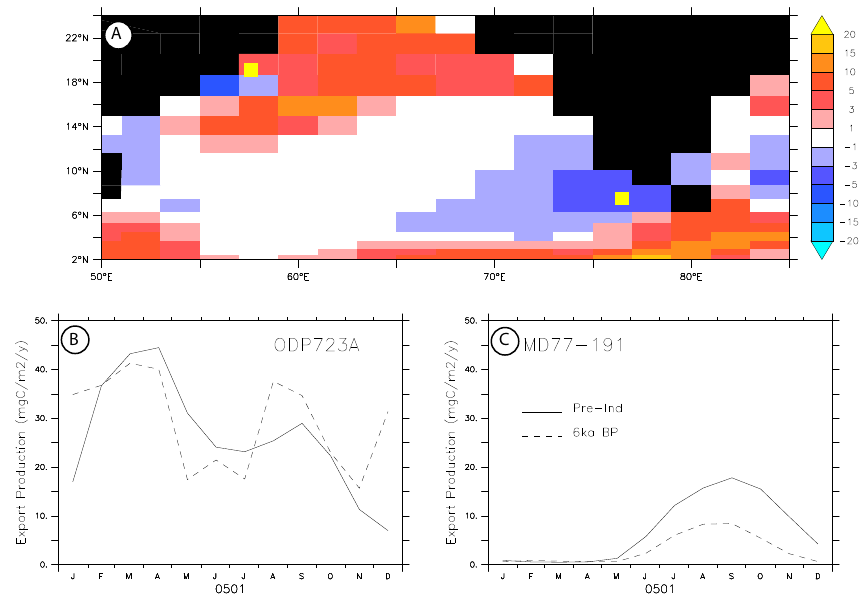
Fig. 6. PISCES outputs. (A) Map showing the differences in export production at 100m (mgCm − 2 yr − 1 ) between the mid-Holocene (6ka) and the pre-industrial control-run simulations. (B) Seasonal variations of export production simulated at 6kaBP and in the control run, at the ODP Site 723. (C) Seasonal variations of export production simulated at 6kaBP and in the control run, at the site of core MD77-191. Yellow squares indicate the location of ODP Site 723 and core MD77-191 in panel (A)